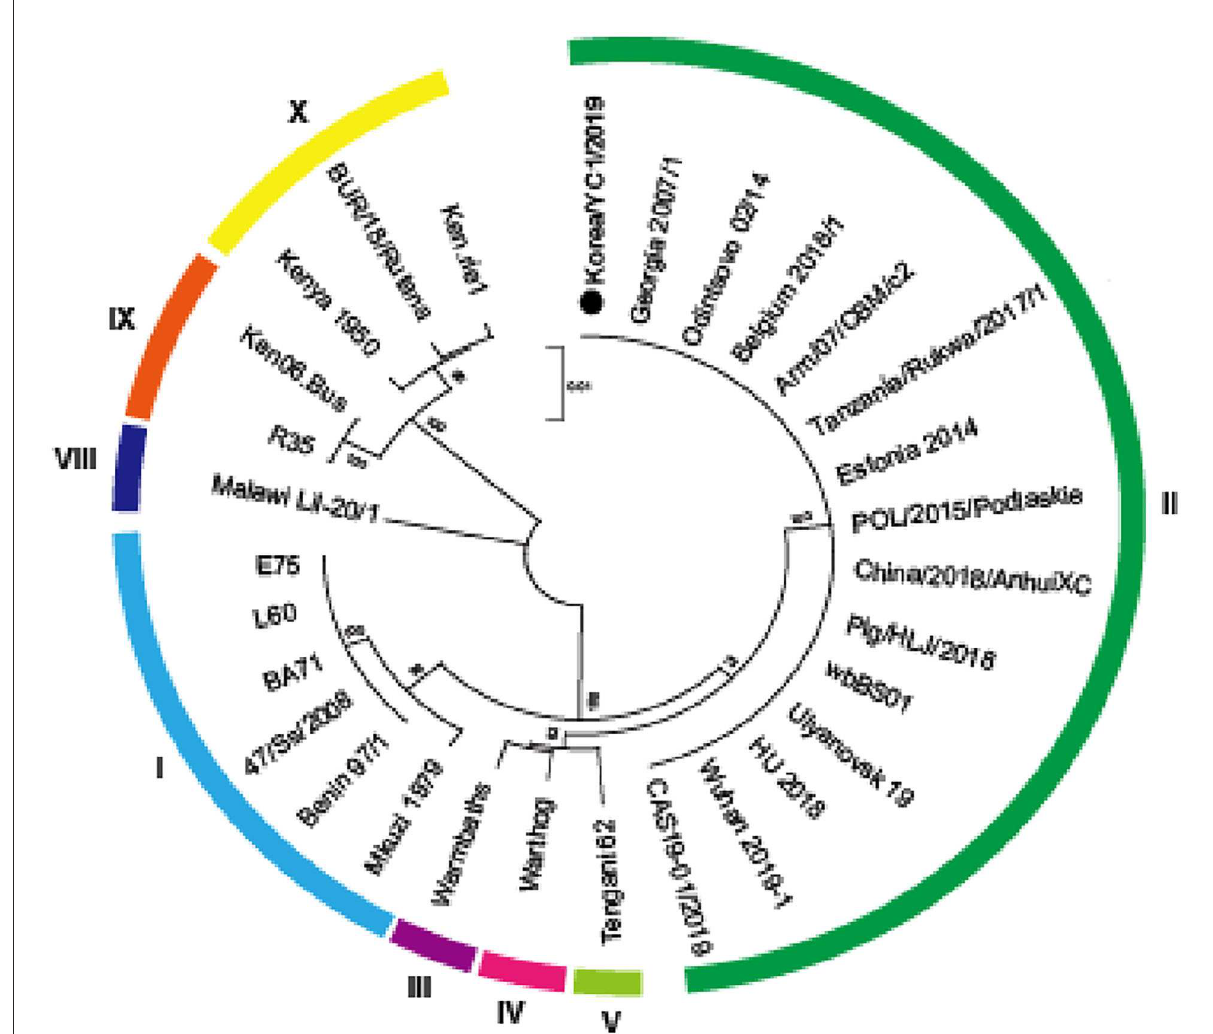
FIGURE3 Phylogenetic relationship of ASFV strains based on p72 ( B646L ). A phylogenetic tree based on the full-length p72 sequence alignment of the Korea/YC1/2019 strain and 29 public ASFV strains. ASFV Korea/YC1/2019 isolated in this study is marked with a black dot. ASFV strains are named by their isolate names. Genotypes I, II, III, IV, V, VIII, IX, and X are labeled in sky blue, green, purple, pink, yellow-green, blue, yellow, and orange, respectively. Phylogeny was inferred following 1,000 bootstrap replications and node values show percentage bootstrap support. The scale bar indicates nucleotide substitutions per